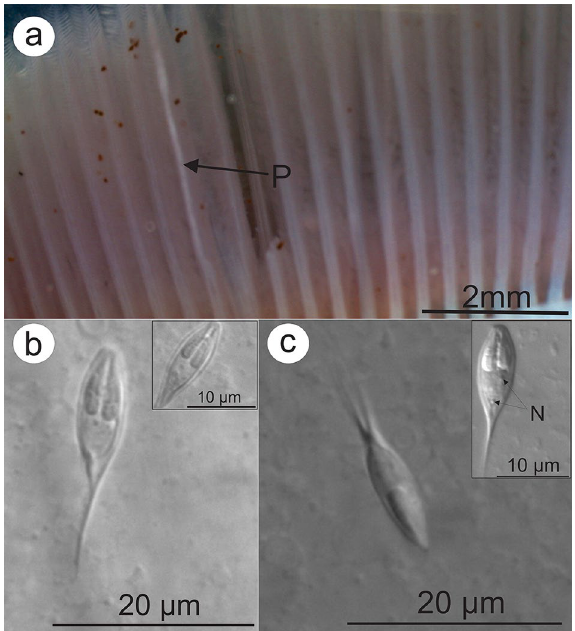
Figure 3. ( a ) Gills of Rhamdia quelen , collected from the Pardo River containing plasmodium (P) inside the gill filaments. ( b ) Mature myxospore of Henneguya bagre n. sp. found parasitizing the gills in front view. In highlight, the two polar capsules of equal size, elongated, showing 7 turns of the polar tubules inside it. ( c ) Henneguya bagre n. sp. myxospore in side view. In highlight note the binucleated sporoplasm